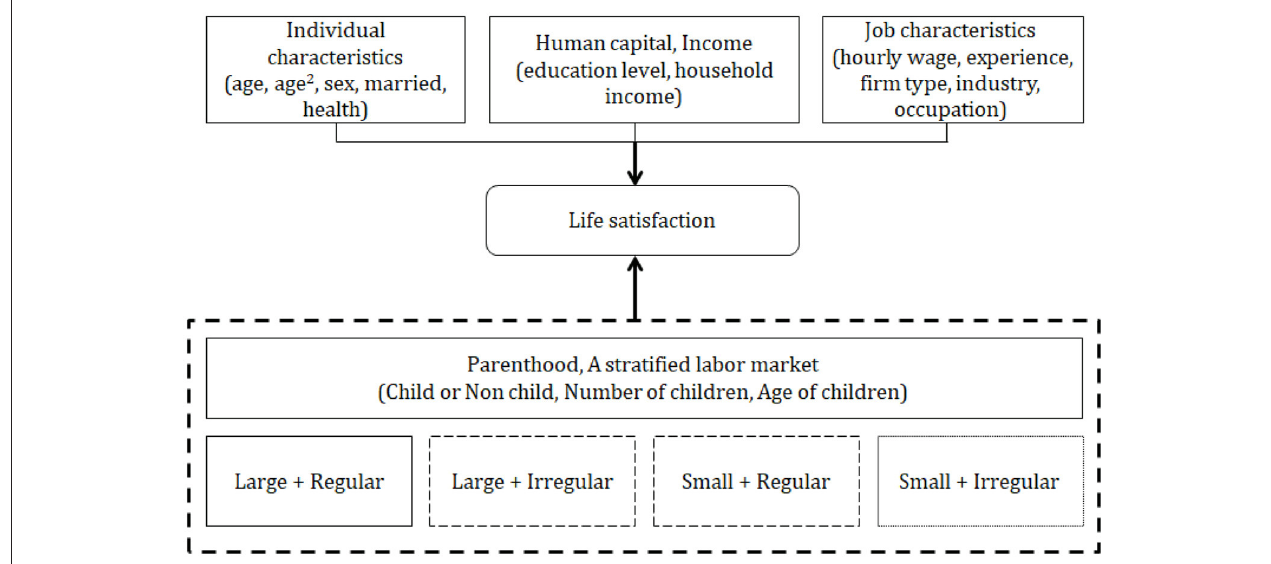
FIGURE 1 | Conceptual framework.